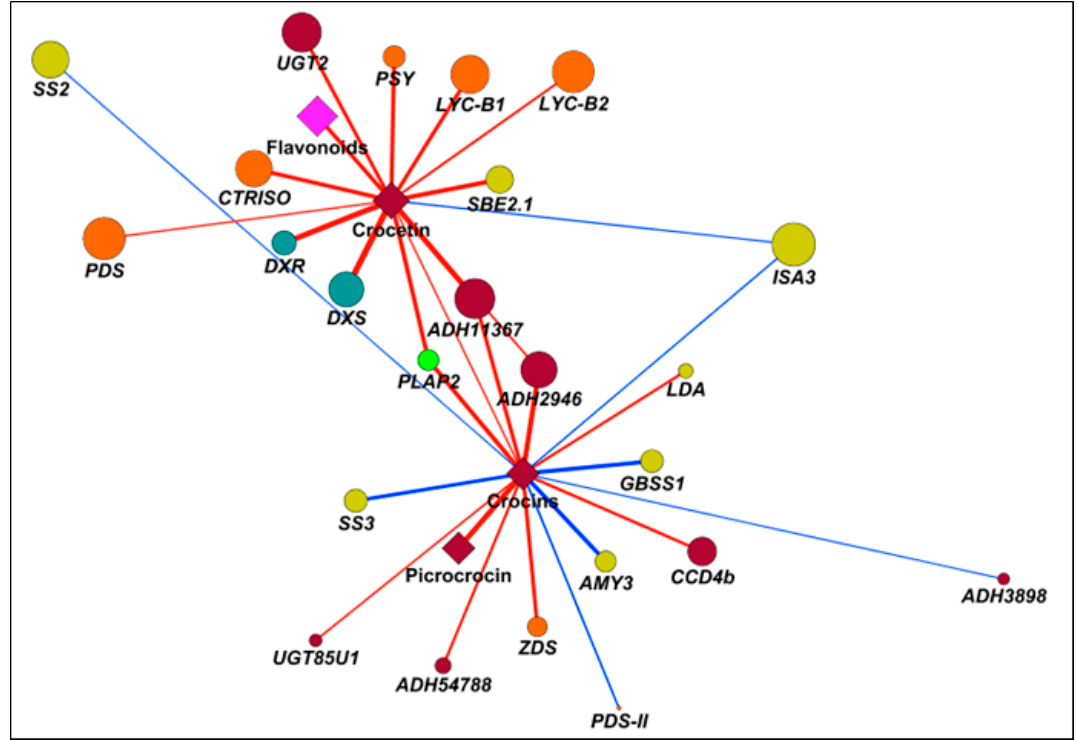
Figure 6. Correlation network of chromoplast genes/metabolites, involved in saffron apocarotenoid synthesis and transport. Genes and metabolites are represented as rounds and diamonds. Different colors identify genes/metabolites involved in MEP (turquoise), carotenoid (orange), apocarotenoid (burgundy), plastid development (green), and starch (yellow) biosynthesis. Blue and red edges refer, respectively, to negative and positive correlations; only correlations >|0.65| are shown. Edge width and node size were drawn according, respectively, the Pearson correlation coefficient (| p |) and the node strength (ns). Edge length was inversely proportional to | p |.